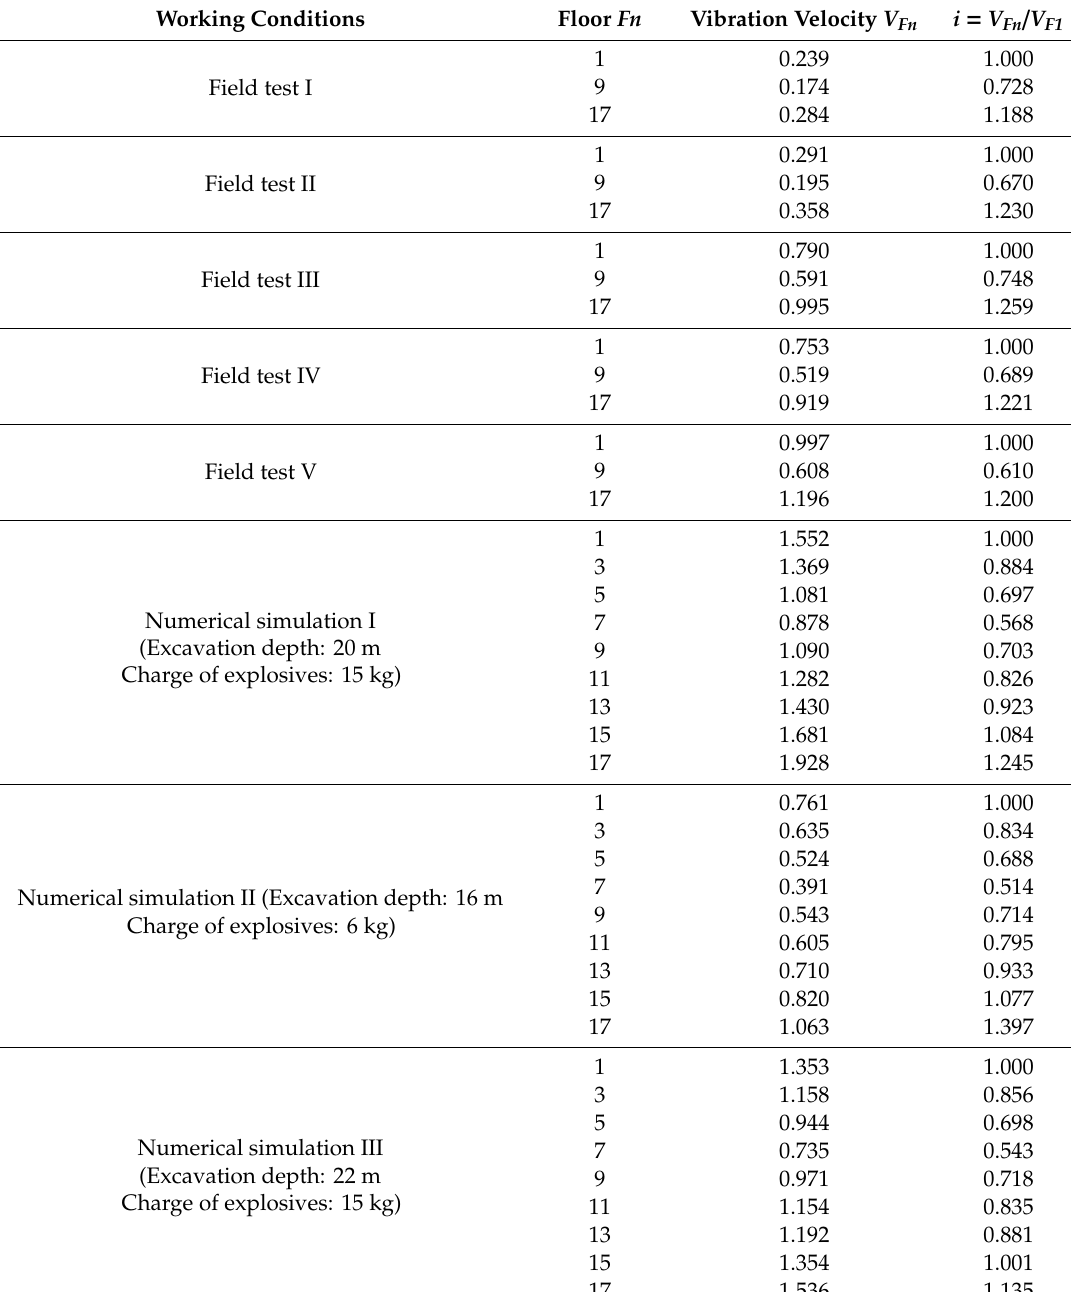
Table 11. V Fn and ratio